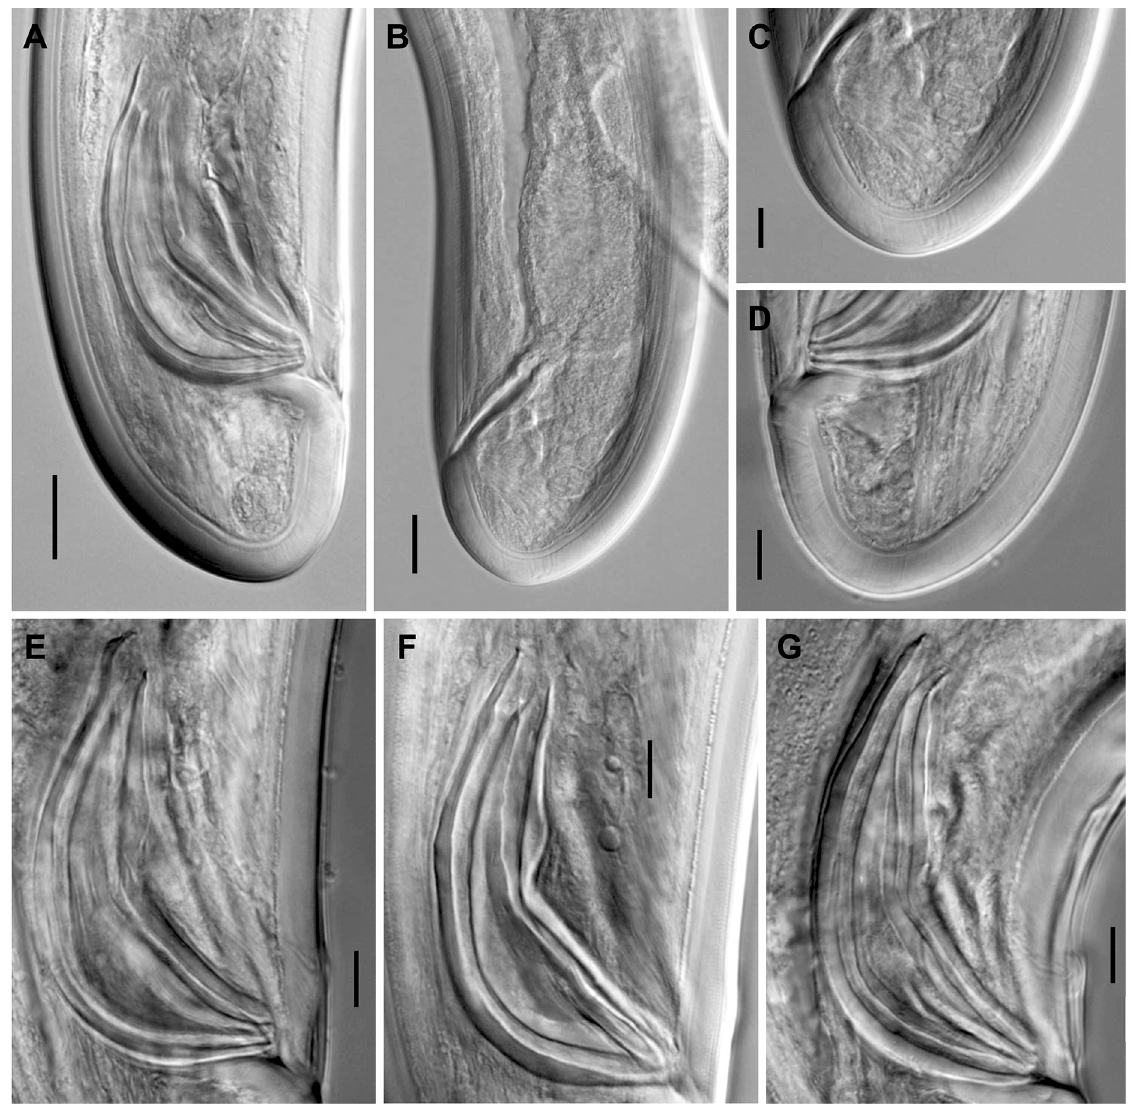
Fig. 3. Sectonema tropicum sp. nov. (LM). A . ♂, posterior body region. B . ♀, posterior body region. C . ♀, caudal region. D . ♂, caudal region. E–G . Spicules, E–F also showing the lateral guiding piece. Scale bars: A–B = 20 μm; C–G = 10